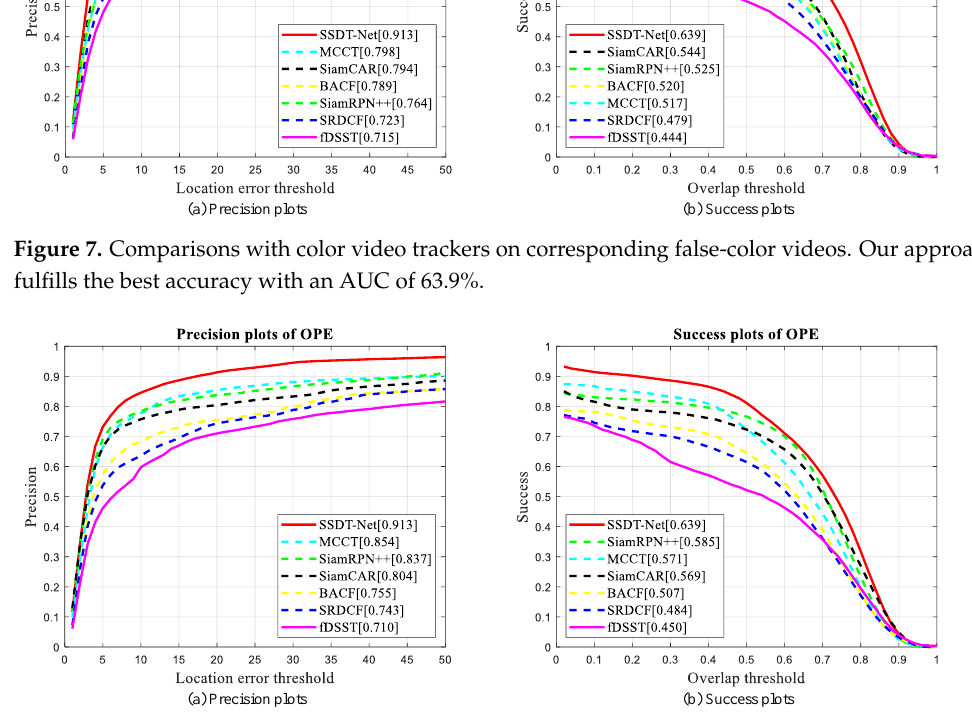
Figure 8. Comparisons with color video trackers on RGB videos. Our approach exceeds all the other trackers. Table 2. Performance comparison with color video trackers in terms of the AUC and DP@20P.